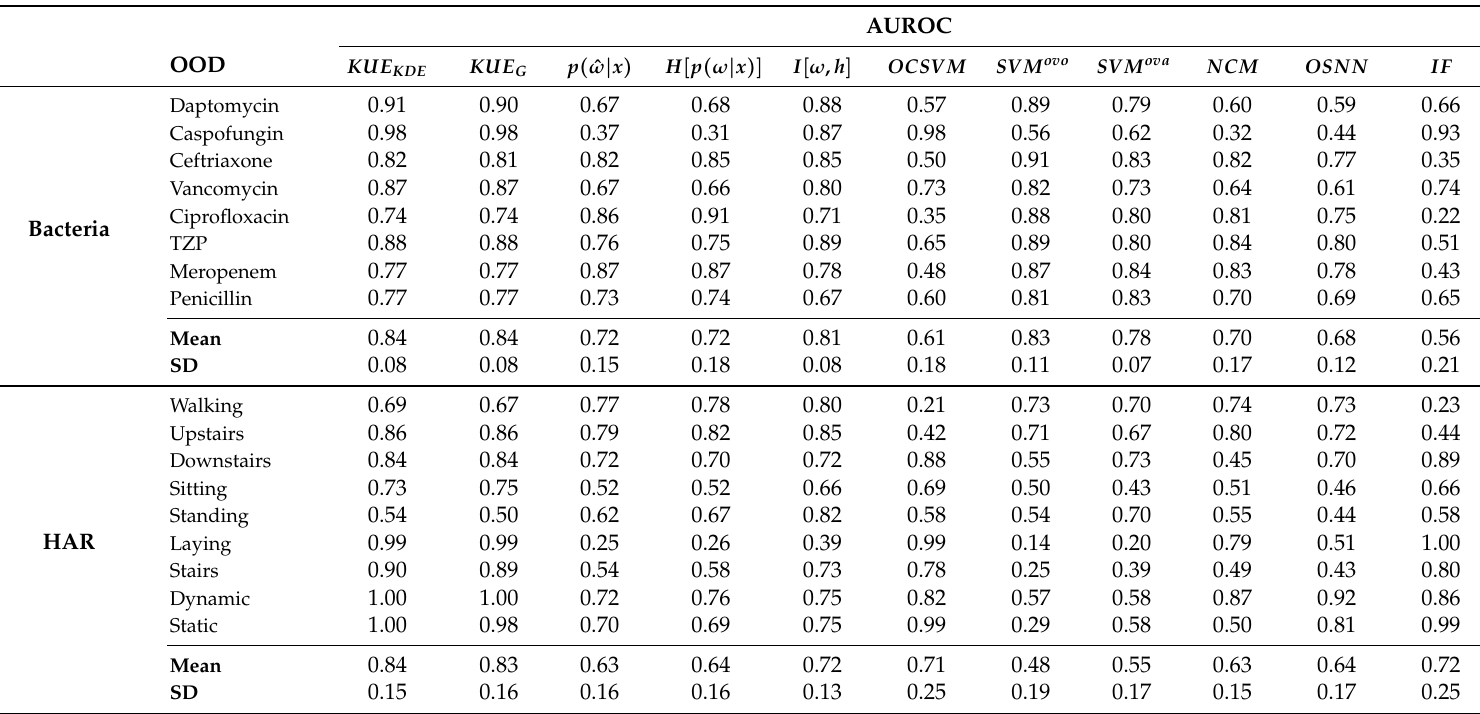
Table 2. AUROC for detecting OOD test inputs using two variants of KUE (KDE and Gaussian) and other baseline methods on 4 datasets. The Mean and Standard Deviation (SD) over OOD combinations is presented after each dataset. All values are averages over 10 consecutive